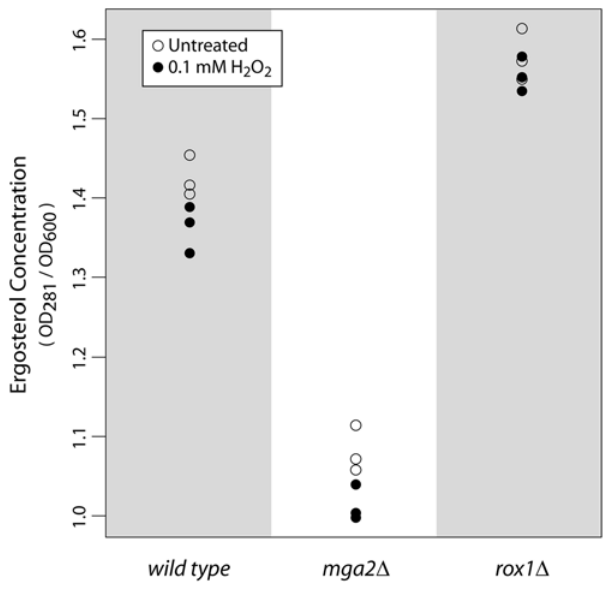
Figure 6. Dynamics of ergosterol following mild treatment with hydrogen peroxide. Following an n-heptane extraction (see Meth- ods), the presence of ergosterol is detected at 281 nm. The ergosterol concentration (relative to the number of cells [OD 600 value] in the original culture) is reported for wild type , mga2 D , and rox1 D strains in three paired trials with and without mild hydrogen peroxide pretreatment.